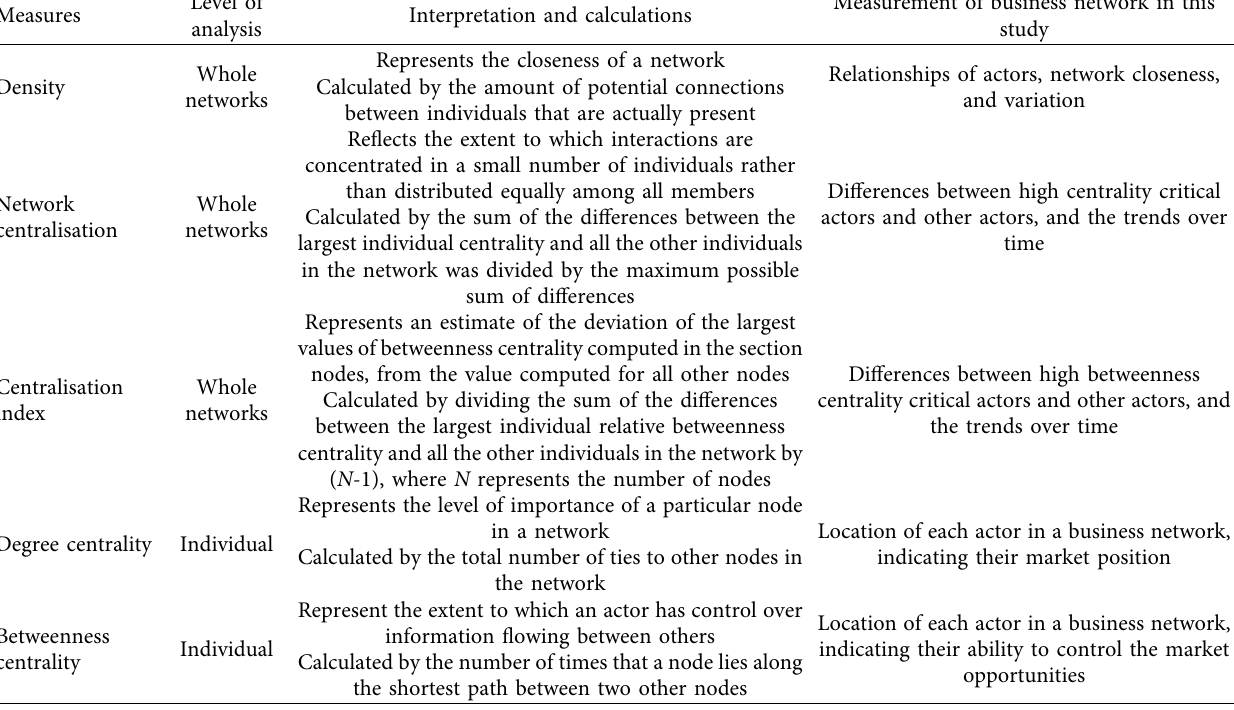
Table 3: Selected SNA measures for the analysis of interorganisational business